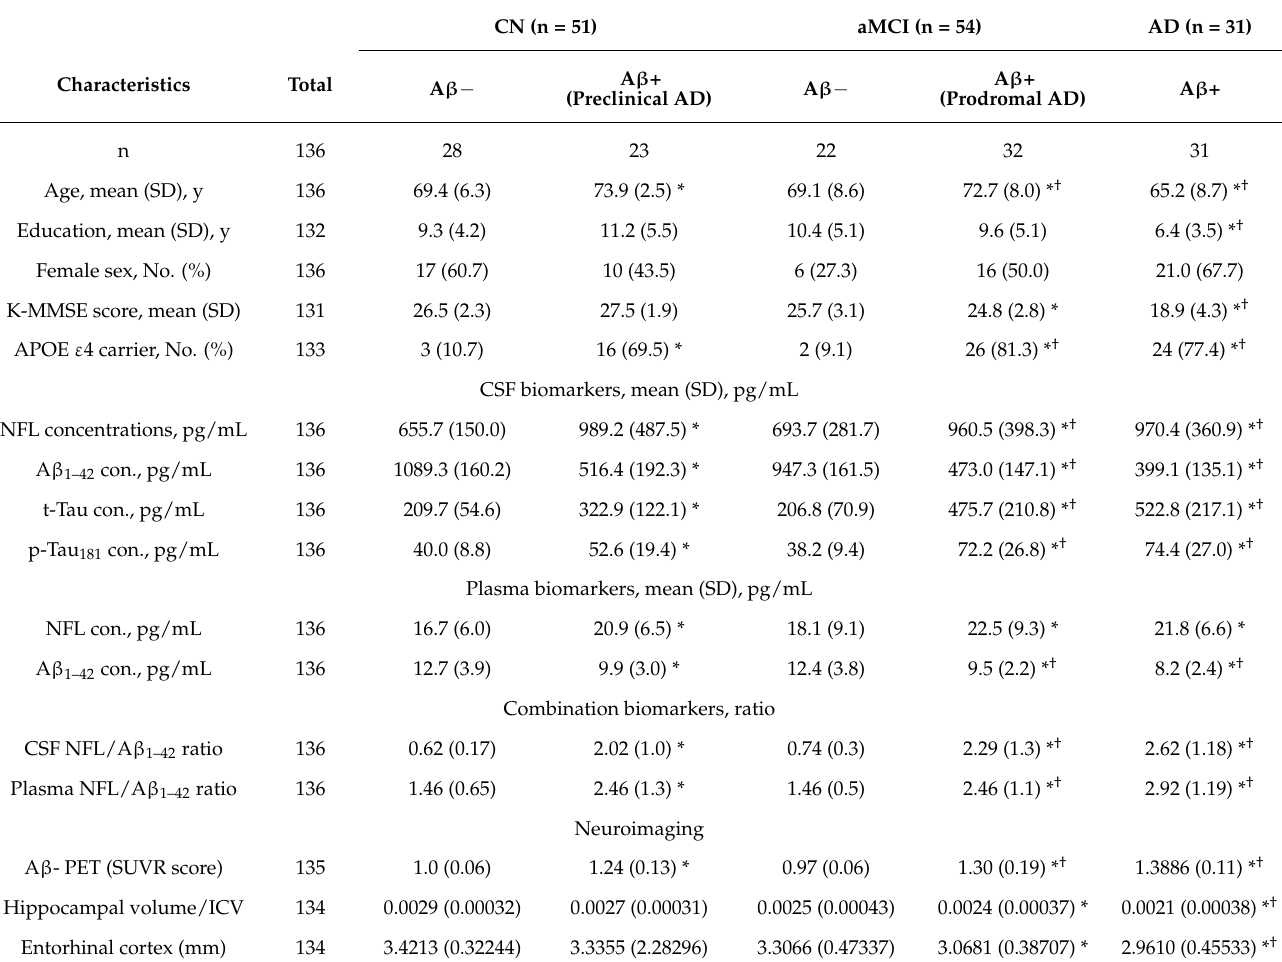
Table 1. Patient demographics (n =